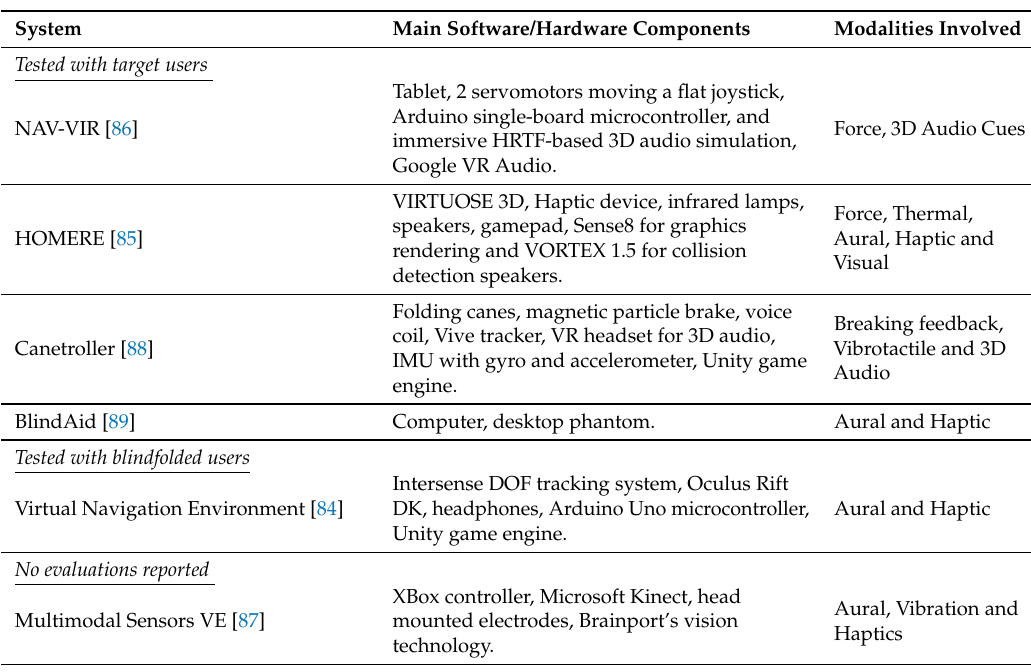
Table 4. Multimodal virtual navigation